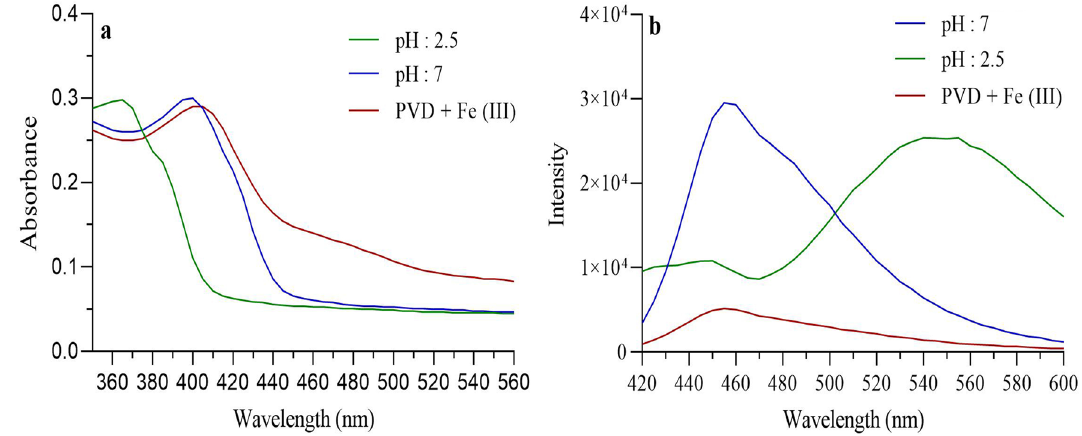
Figure 2. Characterization of the purified PVD from P. fluorescens IBRC-M 10752 strain using ( a ) UV absorption spectroscopy ( λ max : 400 nm); and ( b ) fluorescence emission at excitation 400